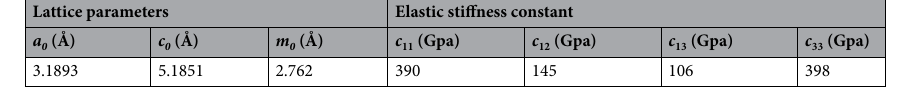
Table 2. Lattice constants and elastic stiffness coefficients for perfect hexagonal GaN.